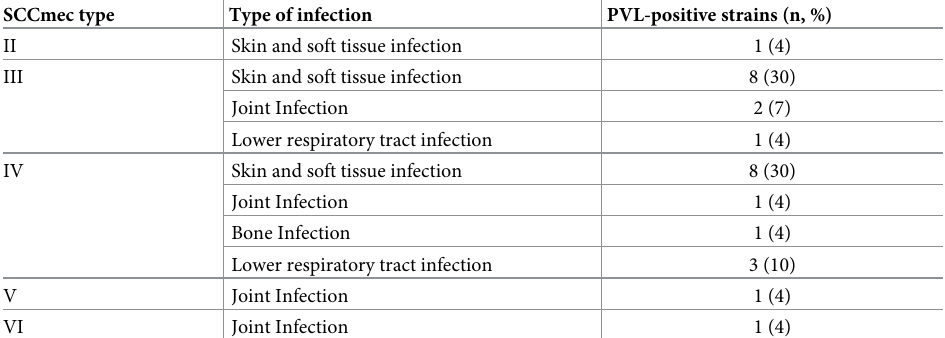
Table 3. Presence of SCC mec types and prevalence of the Panton-Valentine Leukocidin gene in MRSA isolates (n = 27). SCCmec